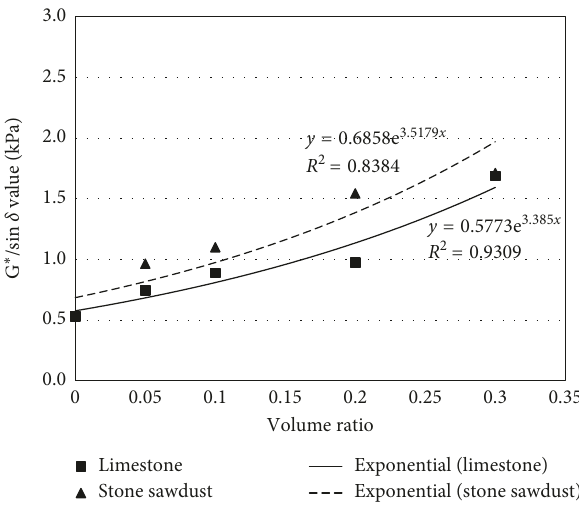
Figure 7: Rutting behavior of asphalt mastics at 70 ° C.